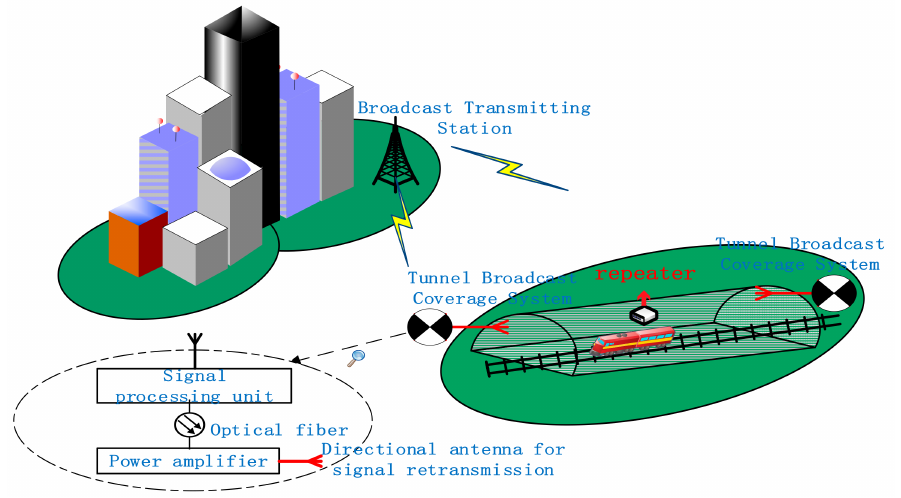
Figure 1. Schematic diagram of broadcast coverage